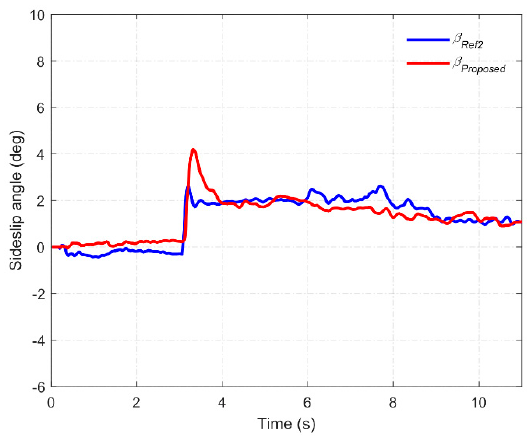
Figure 18. Comparison of sideslip angles.